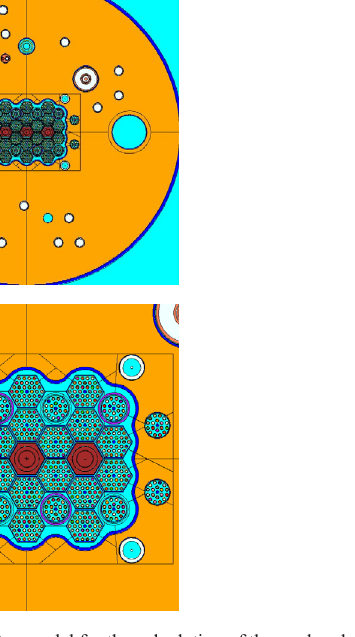
Fig. 5. The reactor model for the calculation of the nuclear heating rate at the CN hole.